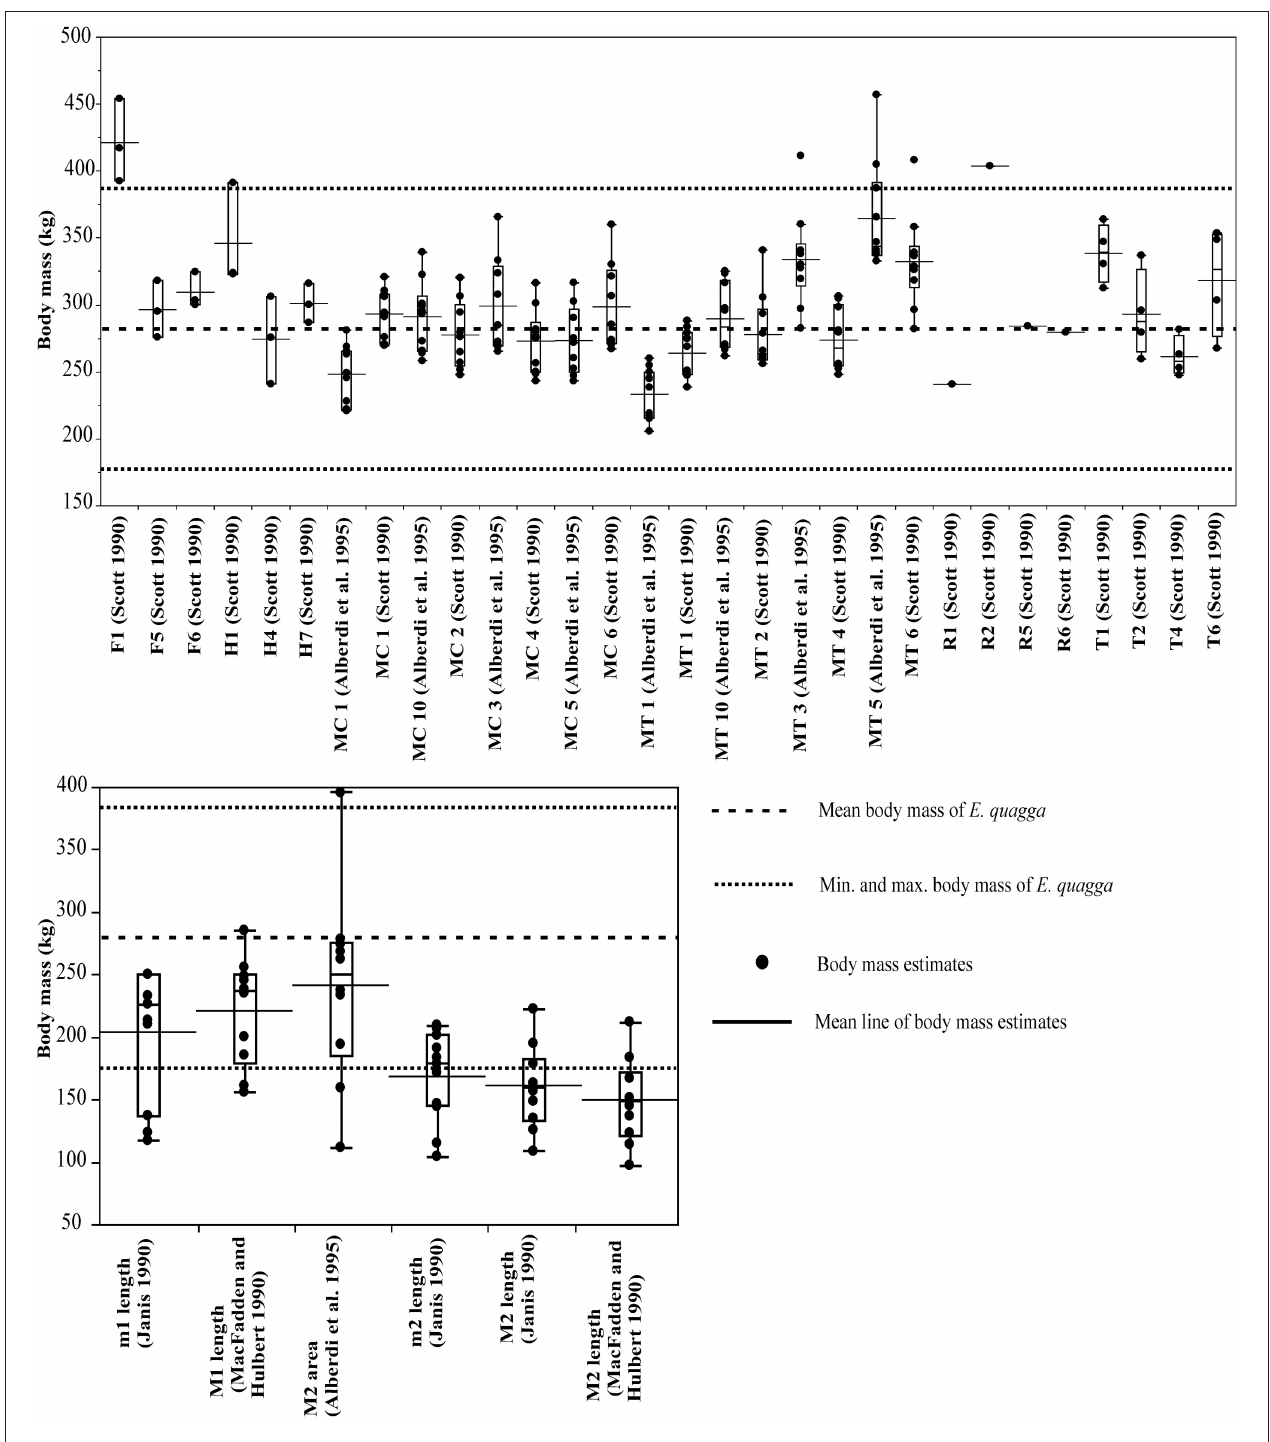
FIGURE 2 | Visual comparisons of body mass estimates from various skeletal and dental measurements with reported mean, minimum and maximum body mass of the plains zebra ( Equus quagga ). Box plots and mean lines are provided for the body mass estimates from each skeletal and dental measurement, and the reported minimum, maximum and mean body mass are from Nowak (1999). The central line in the box plot indicates the median, the box covers the interquartile range (IQR) and the upper and lower whiskers are 1.5*IQR. In addition, a mean line is shown as a horizontal line extending outside the vertical limits of the box. Bone and measurement codes are as in Table 1